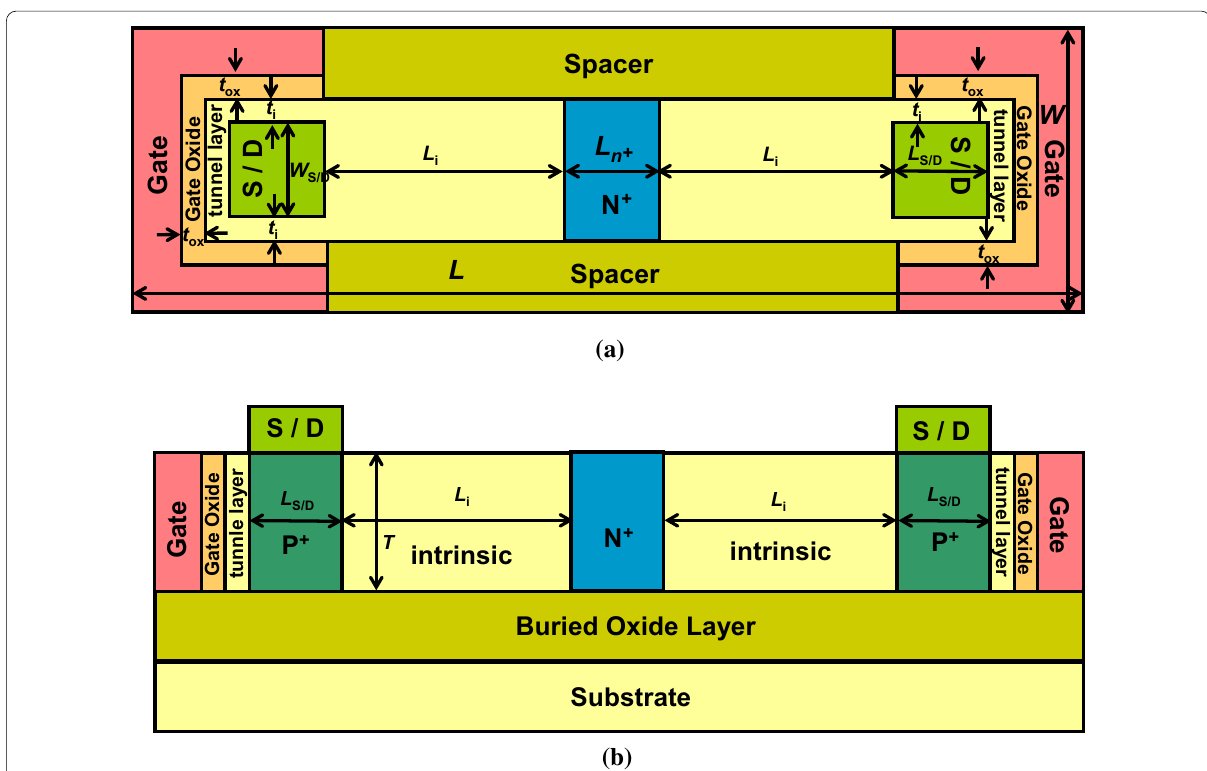
Fig. 1 a Schematic top view of the bilateral gate‑controlled N‑Type B‑TFET with planar channel. b Cross‑view of the bilateral gate‑controlled N‑Type